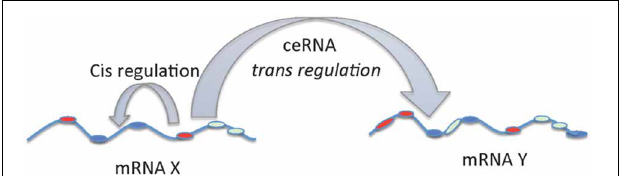
FIGURE 2 | cis and trans regulation of mRNA. The MREs in the 3 (cid:2) UTR of mRNA can act as cis regulatory elements affecting its own stability and levels via miRNAs. On the other hand, MREs in the mRNAs functioning as ceRNAs can regulate the levels and activity of another mRNA by trans